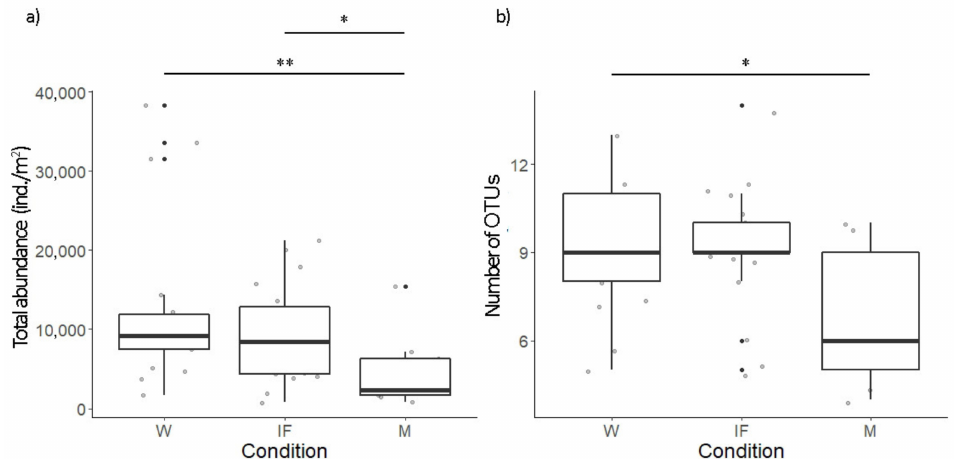
Figure 4. Boxplots of ( a ) total abundance (ind./m 2 ) and ( b ) number of OTUs under each condition. The bottom and top of each box represent the lower and upper quartiles, respectively; the line inside each box shows the median and whiskers indicate minimal and maximum observations. Asterisks mean: * p ≤ 0.05, ** p ≤